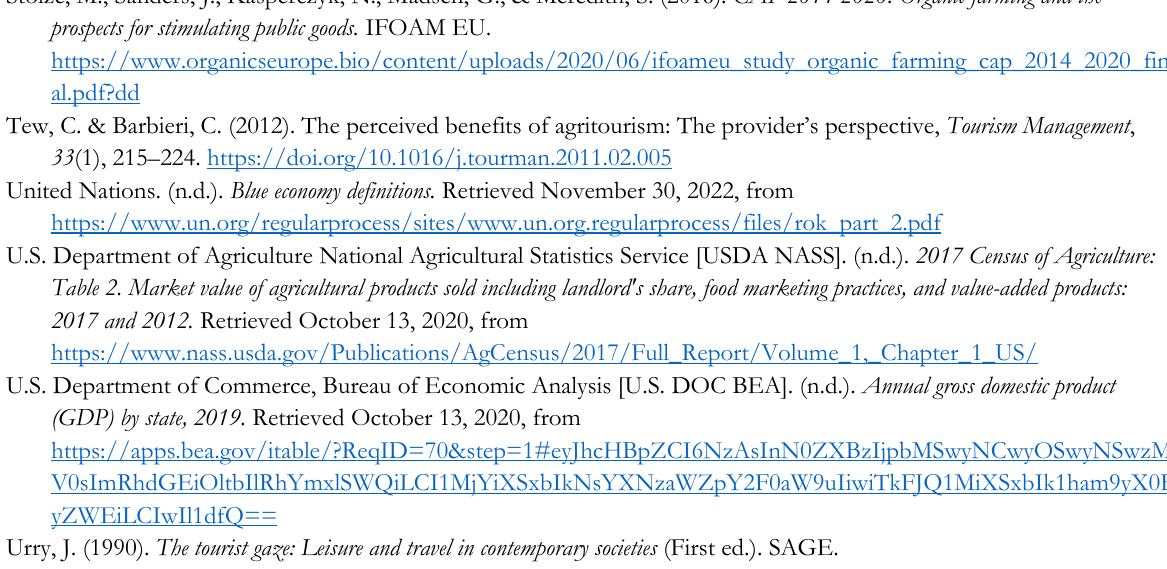
Table 2. Market value of agricultural products sold including landlord's share, food marketing practices, and value-added